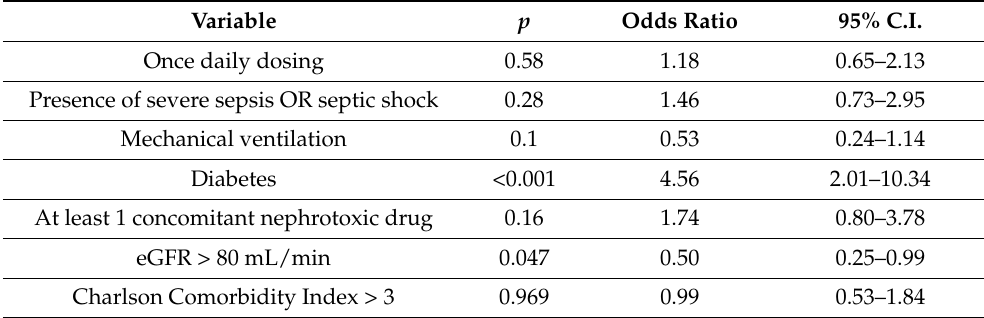
Table 4. Multivariable logistic regression analysis of risk factors for nephrotoxicity (RIFLE)– Propensity matched cohort (n =